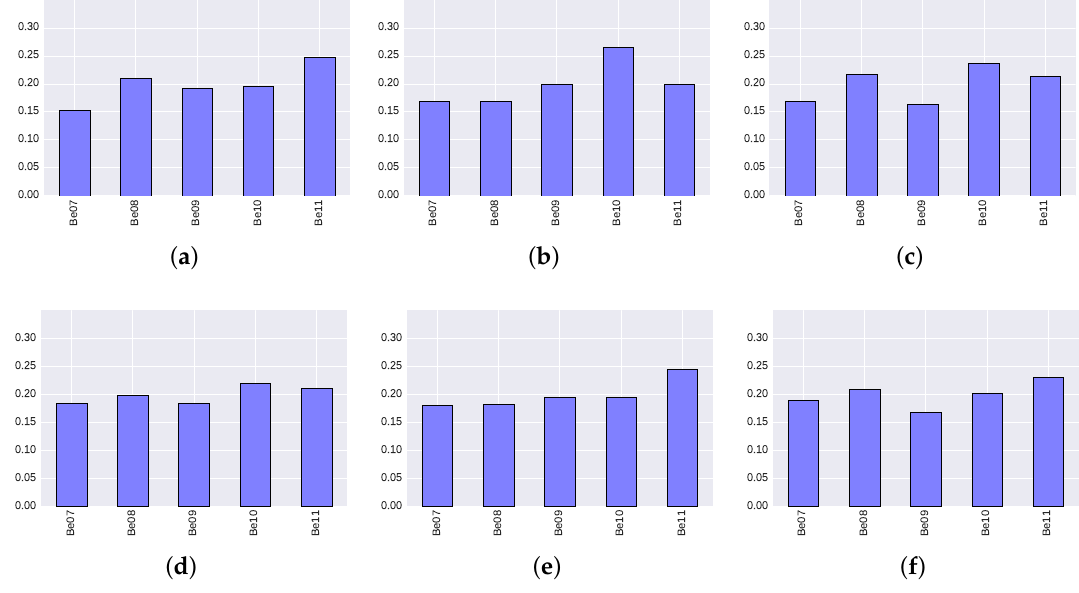
Figure 8. Relevance score of each BLE4.0 beacon for ExtraTrees algorithm for different transmission power ( Tx ) levels. ( a ) Tx = 0x01; ( b ) Tx = 0x02; ( c ) Tx = 0x03; ( d ) Tx = 0x04; ( e ) Tx = 0x05; ( f ) Tx =